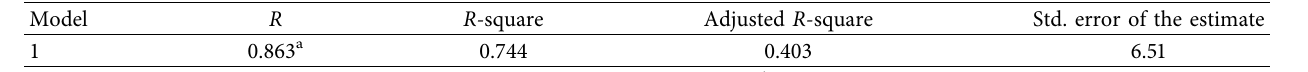
Table 11: Regression values for predictor.